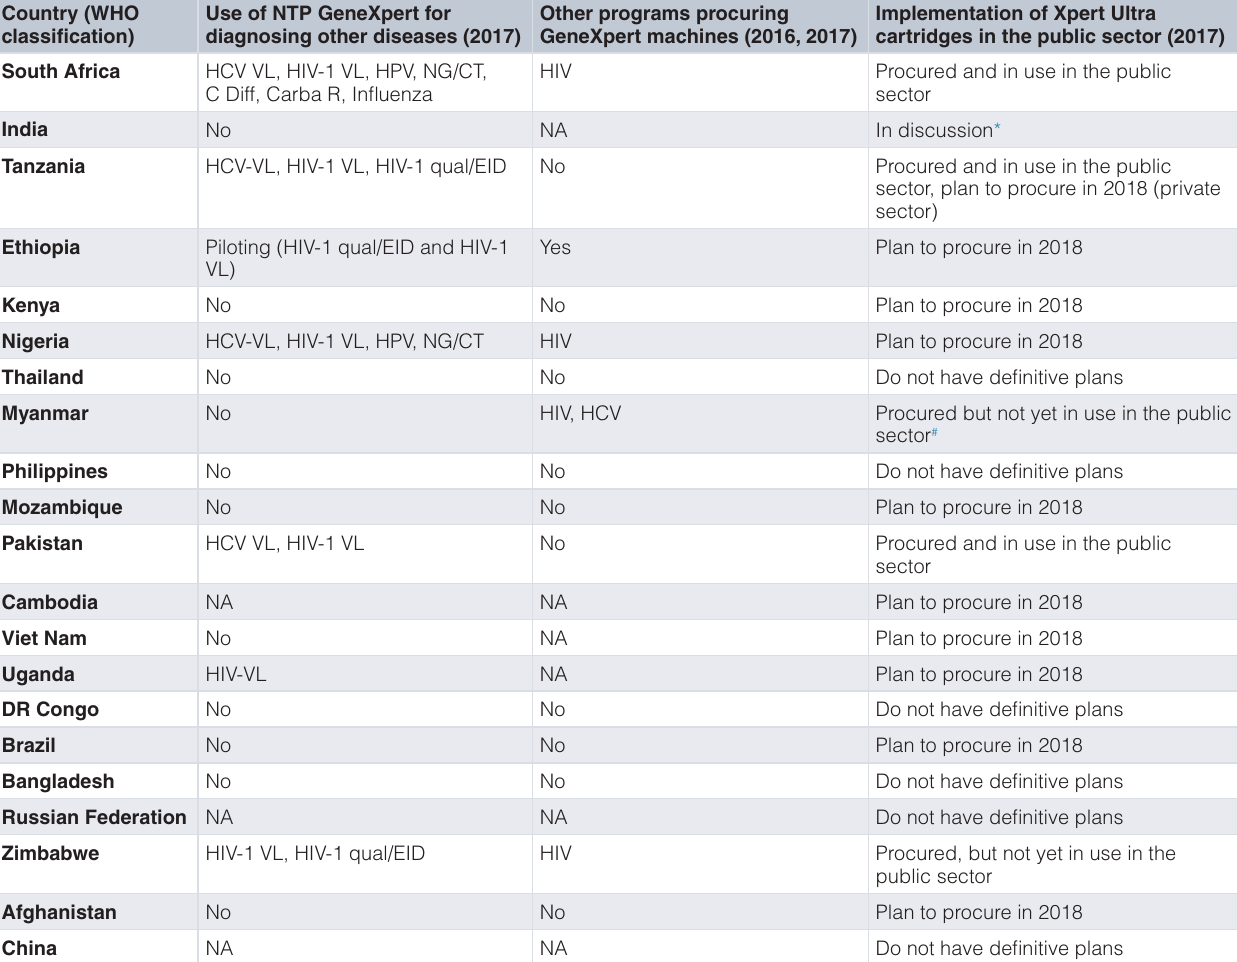
Table 1. Other public sector utilization of GeneXpert in 21 high tuberculosis (TB) burden countries (2016–2017). Country (WHO